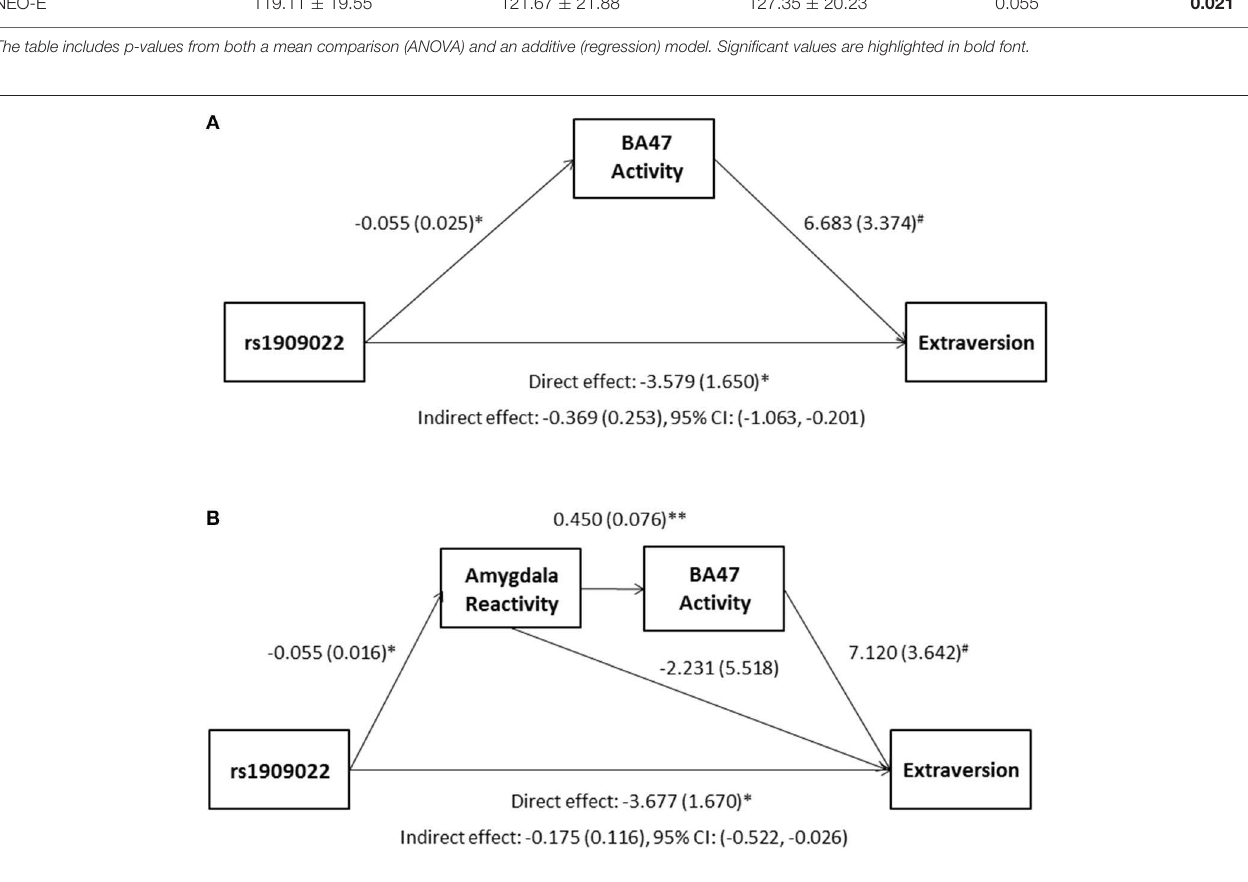
FIGURE 8 | Results from mediation models wherein activity in BA47 mediated the association between rs1909022 genotype and extraversion scores by itself (A) or in conjunction with amygdala reactivity (B). Raw regression coefficients are presented for each path, along with standard errors in parentheses. Bootstrapped 95% confidence intervals are presented for the indirect (mediation) effects. ** p < 0 . 005 , * p < 0 . 05 , # p < 0 . 10 . CI, Confidence